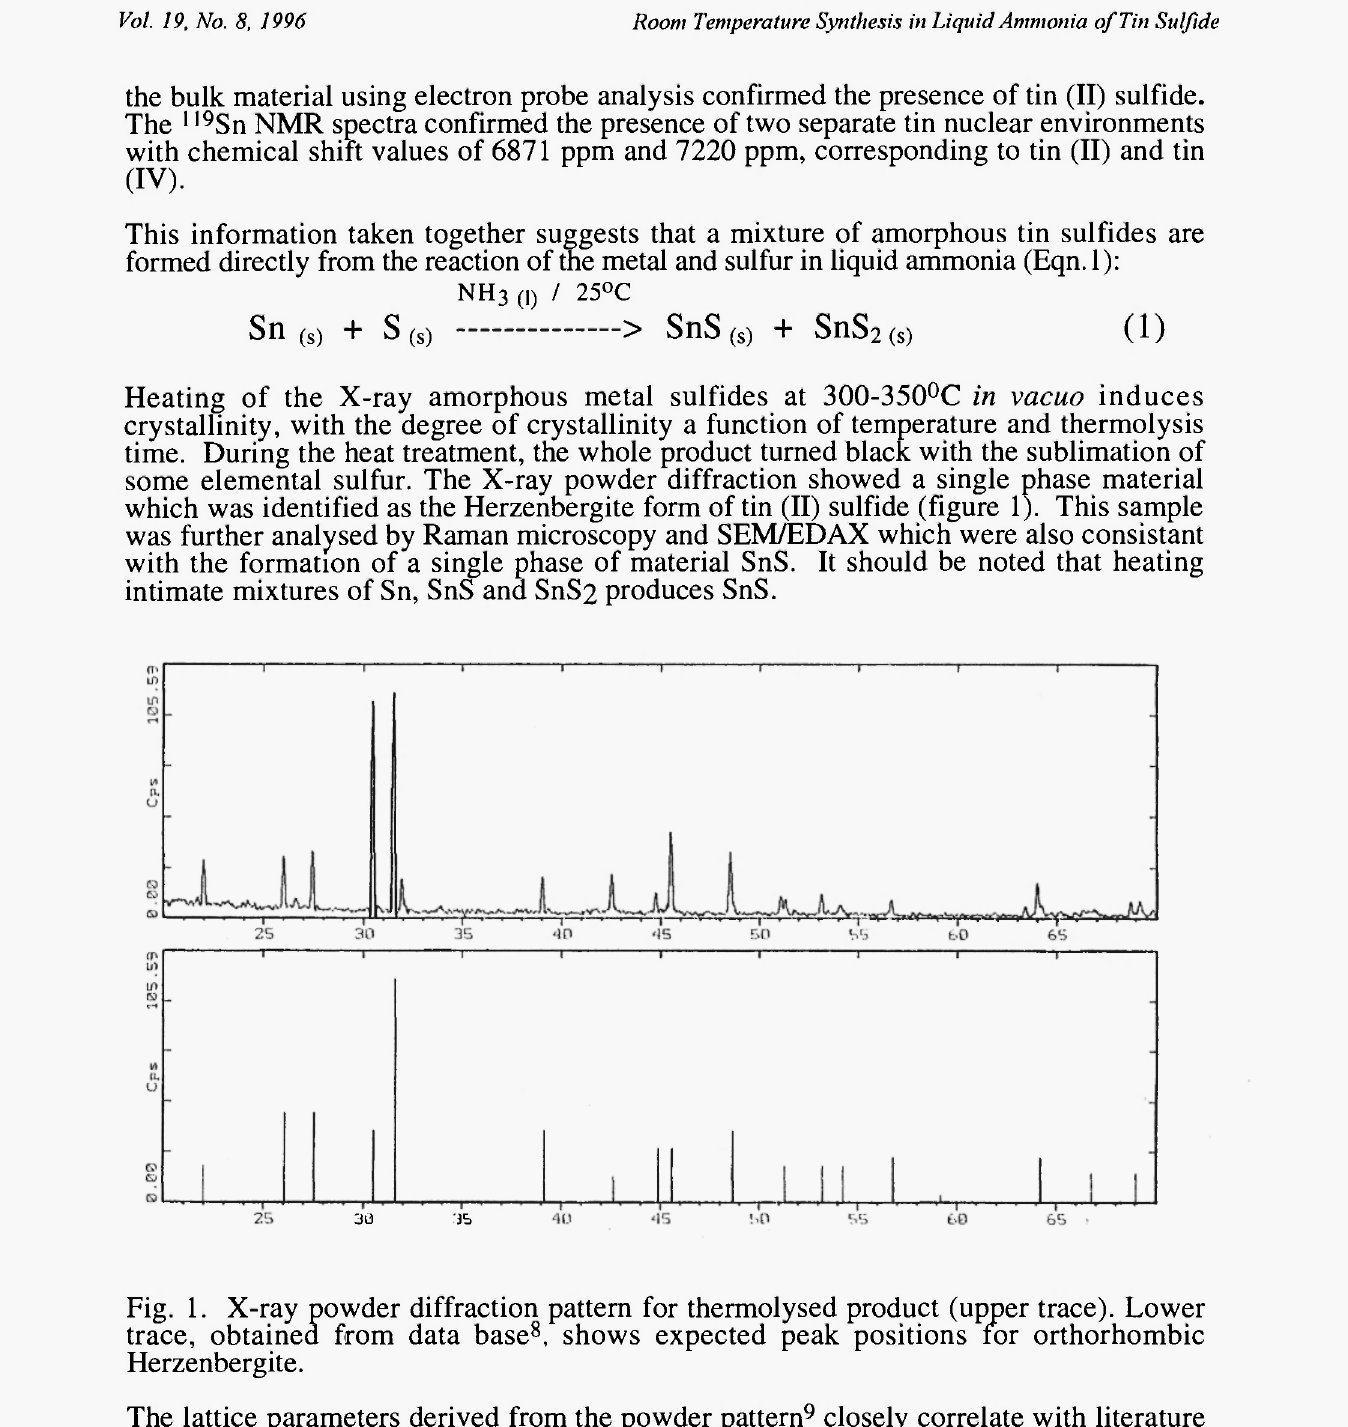
Fig. 1. X-ray powder diffraction pattern for thermolysed product (upper trace). Lower trace, obtained from data base 8 , shows expected peak positions for orthorhombic